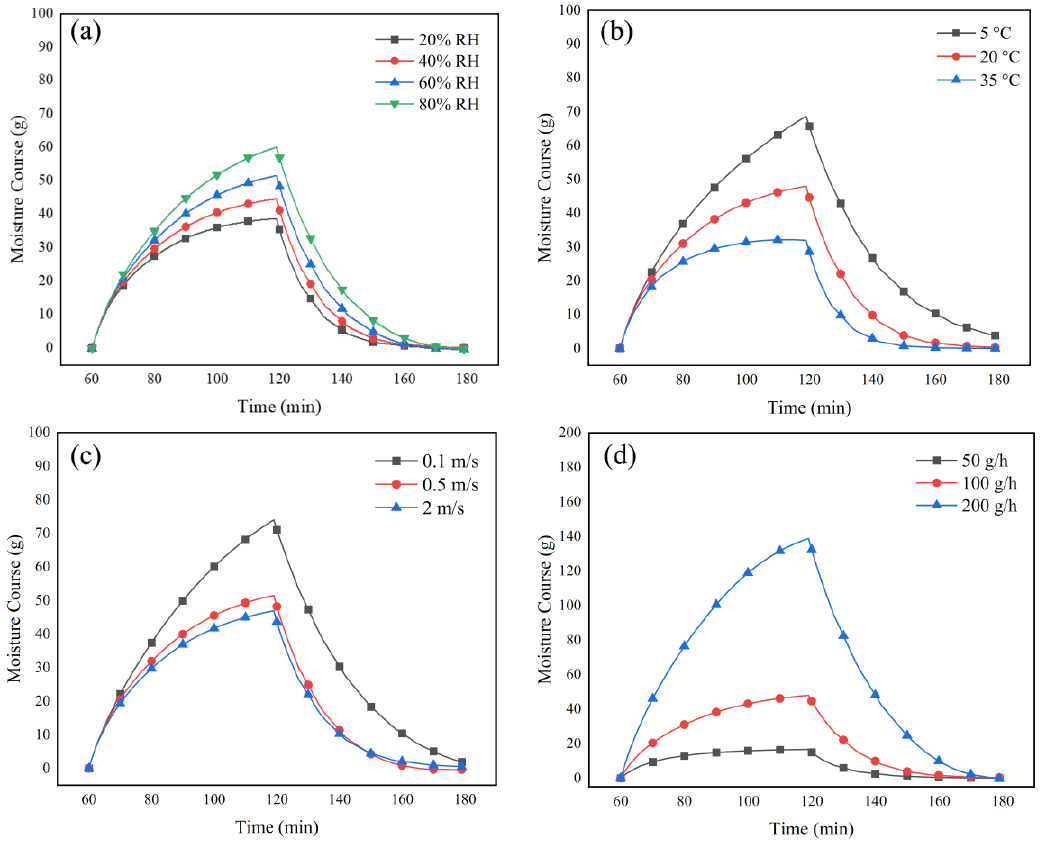
Figure 7. The effect of environmental conditions (( a ) relative humidity, ( b ) ambient temperature, and ( c ) wind speed) and ( d ) sweat rate on the moisture course measurement obtained from the numerical model.